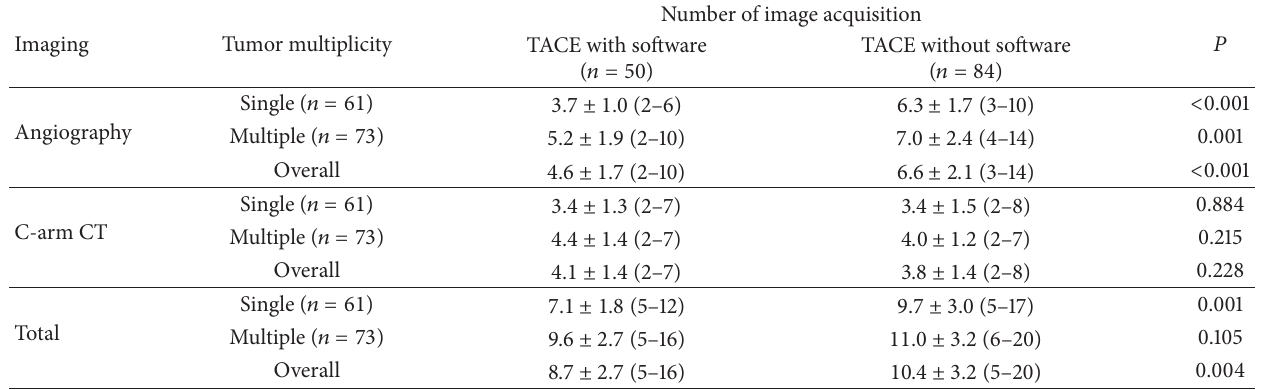
Table 2: Number of image acquisitions required for a single session of chemoembolization. Imaging